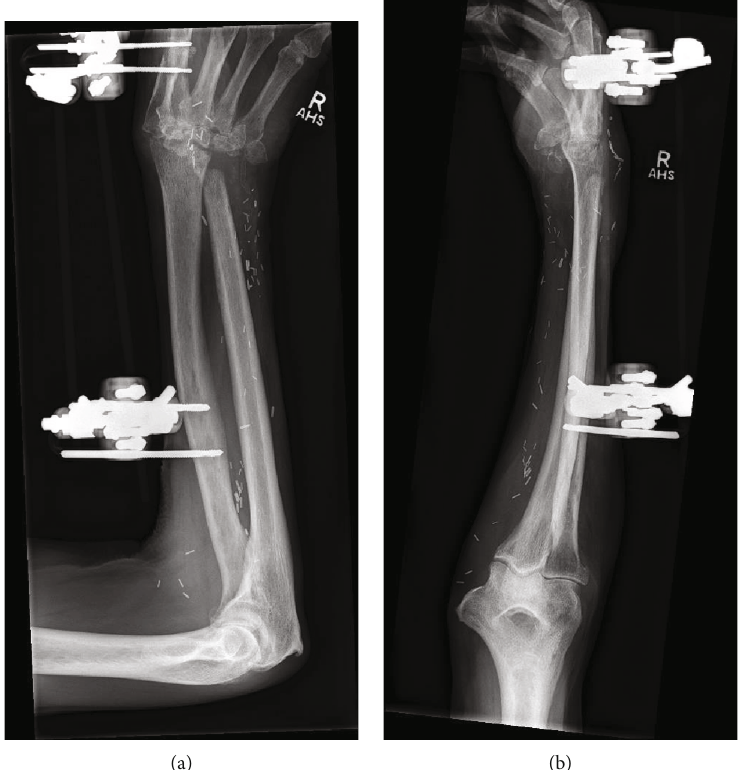
Figure 5: XR of the right hand with the external fi xation device in situ: AP (a) and lateral (b) views. Proximal screws in the midright radius, distal screws in the second metacarpal.